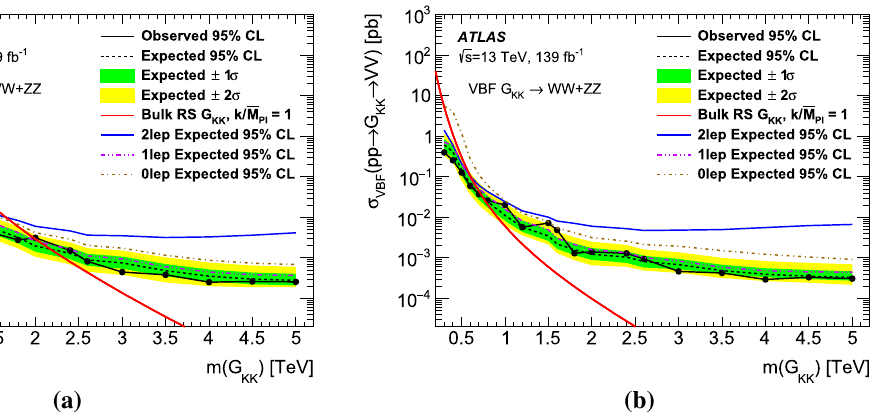
Fig. 15 Observed (black solid curve) and expected (black dashed green (inner) and yellow (outer) bands represent ± 1 σ and ± 2 σ uncer- tainty in the expected limits. Limits expected from individual leptonic curve) 95% CL upper limits on the a ggF and b VBF production cross- √ s = 13 TeV in its diboson ( WW and channels (dashed curves in blue, magenta, and brown) are also shown section of an RS graviton at Z Z ) decay mode as functions of its mass, combining the searches for for comparison. Limits are calculated in the asymptotic approximation below 3 (1) TeV and are obtained from pseudo-experiments above that the G KK → WW and G KK → Z Z decays in the three leptonic chan- for ggF (VBF) production. Theoretical predictions (red solid curves) nels. The theoretical prediction for B ( G KK → WW )/ B ( G KK → Z Z ) for the chosen model as functions of the RS graviton mass are overlaid is assumed for the combination of the WW and Z Z decay modes. The